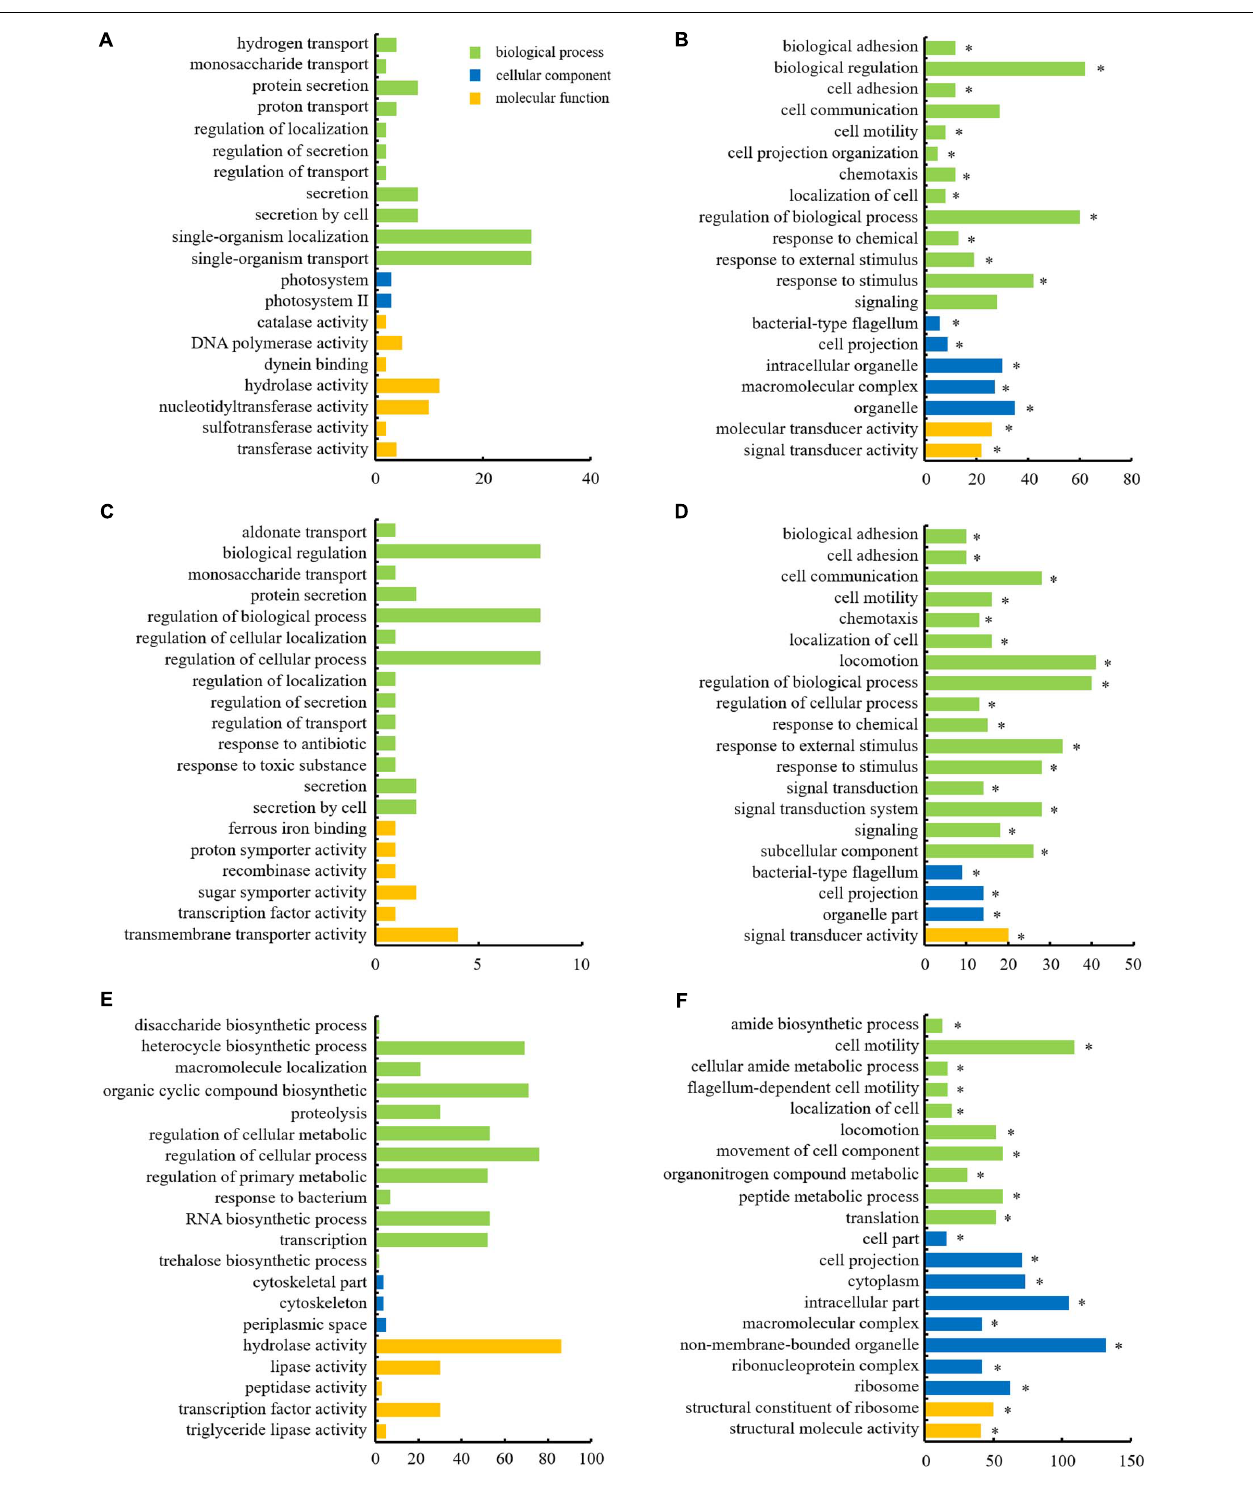
FIGURE 4 | Histograms depicting GO analysis of up- and down-regulated genes in mutants. (A) Up-regulated and (B) down-regulated genes in (cid:49) rpoN1 . (C) Up-regulated and (D) down-regulated genes in (cid:49) rpoN2 . (E) Up-regulated and (F) down-regulated genes in (cid:49) rpoN1N2 . The abscissa axis represents the number of DEGs, and the ordinate axis represents the GO category. Asterisks indicate significant enrichment ( P < 0.05).